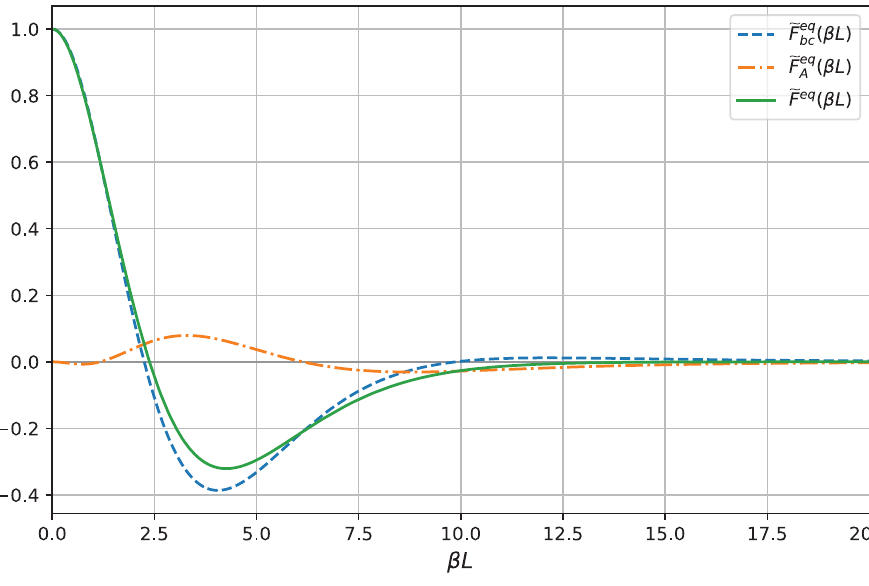
(cid:2) F eq ( β L ) = F eq ( L ,β ) / F qed ( L ) and its decomposition into the part (cid:2) ( β L ) = F eq ( L ,β ) / F qed ( L ) and a part from the variable size F eq bc bc (cid:2) (cid:2) F eq ( β L ) = F eq ( L ,β ) / F qed ( L ), F qed ( L ) = − π 2 . The total force F eq is the same as A A 240 L 4